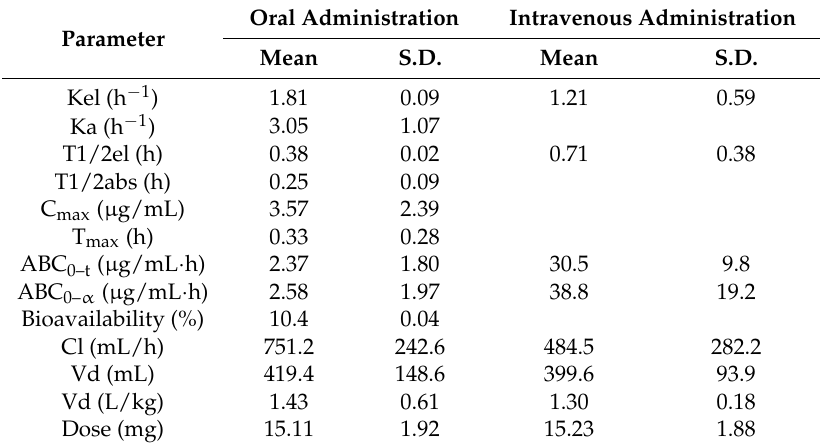
Table 5. The mean pharmacokinetics parameters for Compound 1